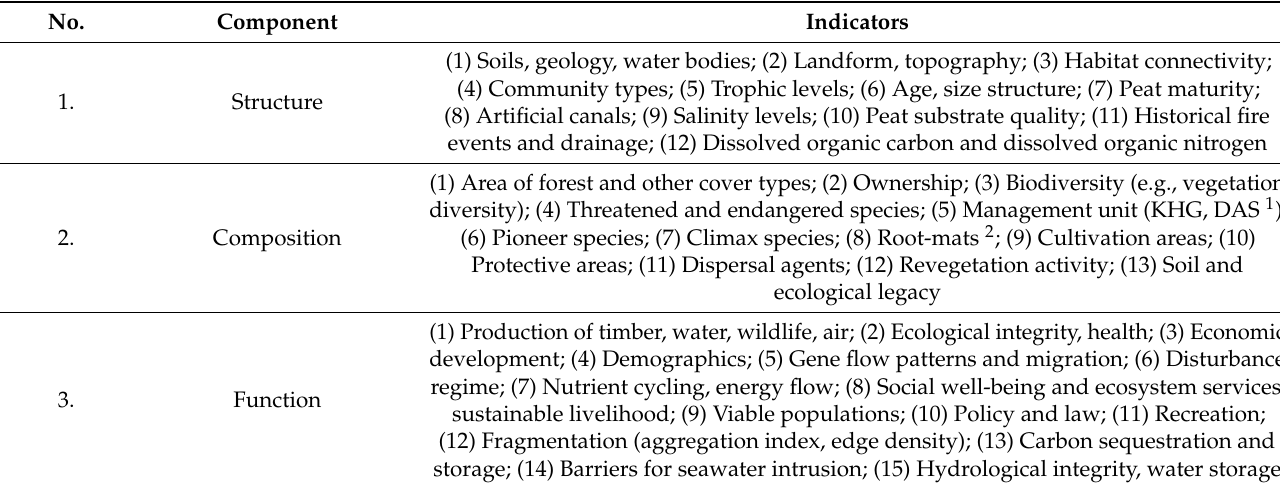
Table 5. List of indicators commonly used to assess the progress of landscape-based restoration activities (compiled from Dey and Schweitzer [98]; other literature cited in this manuscript and from the experience of the